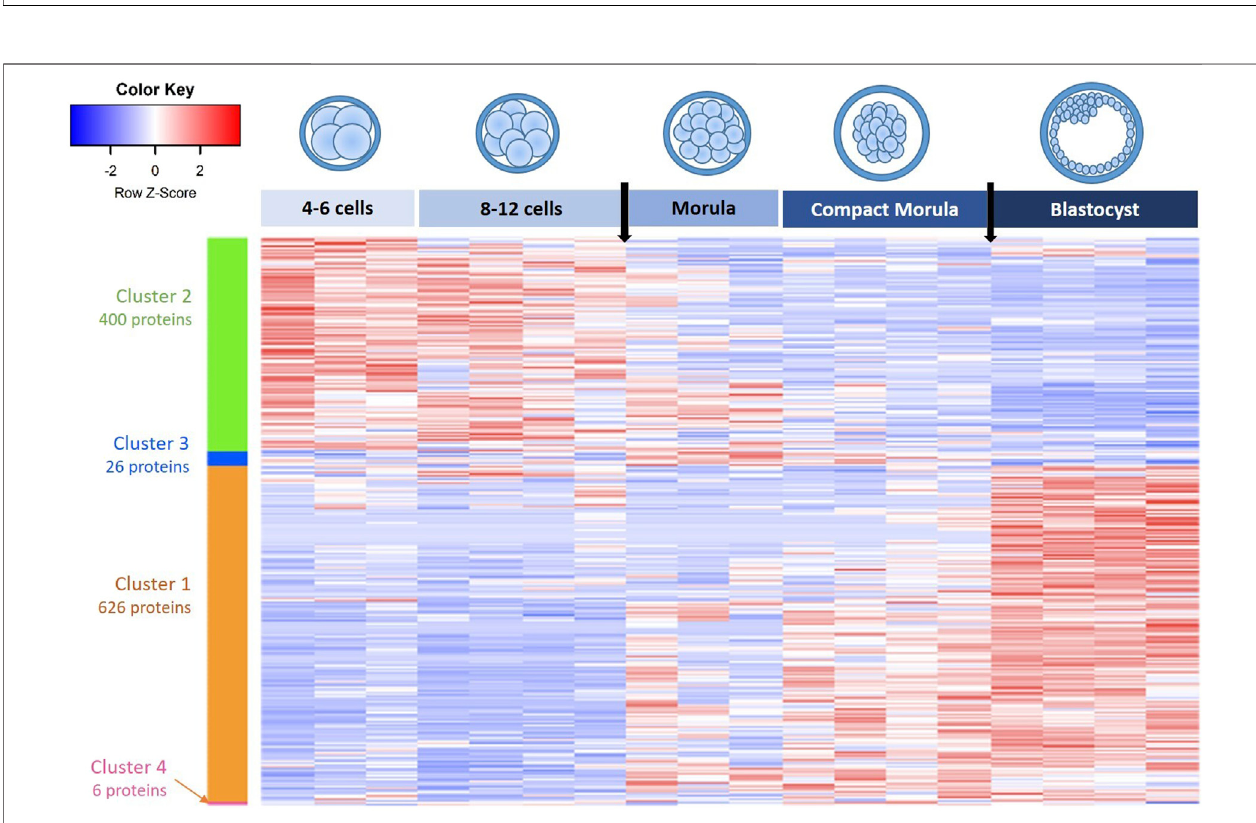
FIGURE 3 | Heatmap and hierarchical clustering of differentially abundant proteins (DAPs) in in vivo embryos from the 4 – 6 cell to blastocyst stages. Each line corresponds to one protein and each row to the abundance values of one embryo pool. Red indicates higher abundance while blue indicates lower abundance compared with other conditions. Clusters of proteins are indicated by colored vertical bars and are numbered in the decreasing order of protein numbers. Black arrows on the top indicate biggest changes in protein abundance at the time of 8-12-cell-to morula and compact morula-to-blastocyst transitions.